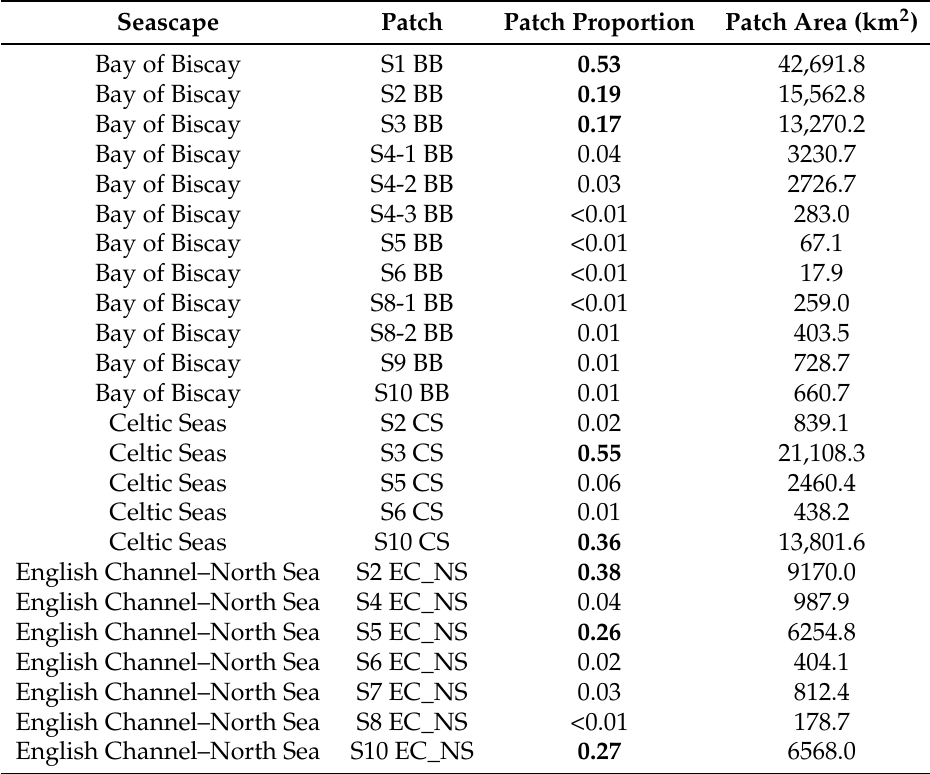
Table 5. Seascape composition metrics, patch proportion in the seascape and patch